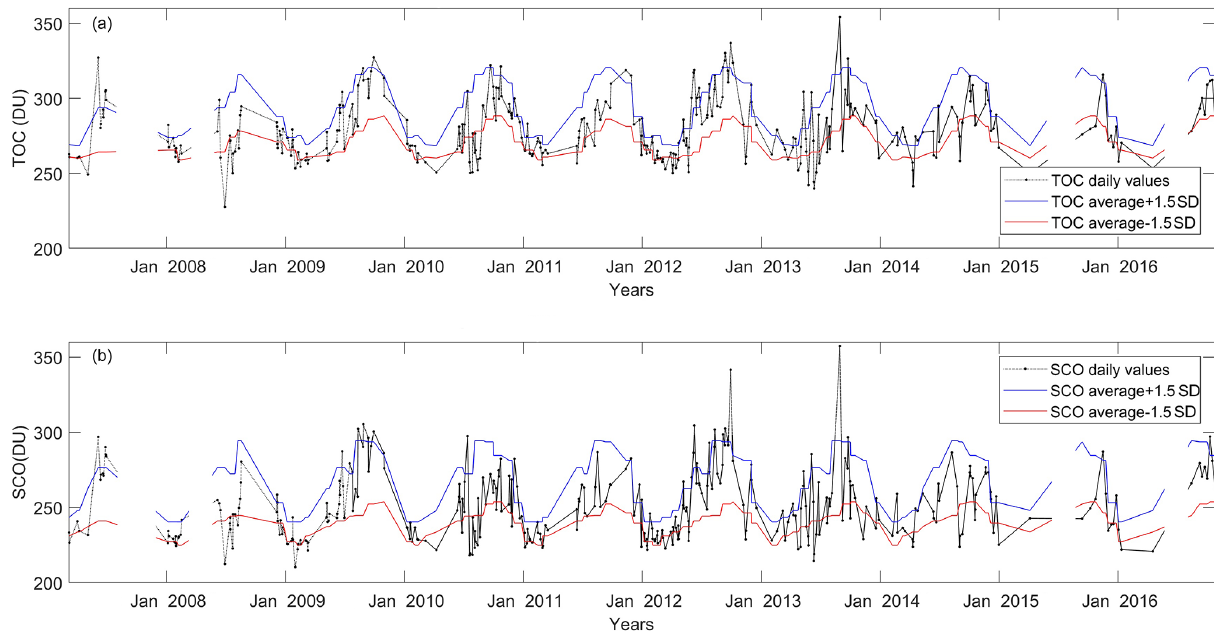
Figure 4. TOC (a) and SCO (b) values on clear-sky days over Cape Point and an indication of the average ± 1 . 5SD limits. Each dot corresponds to a TOC and SCO measurement on a clear-sky day from 2007 to 2016. Interrupted lines indicate missing